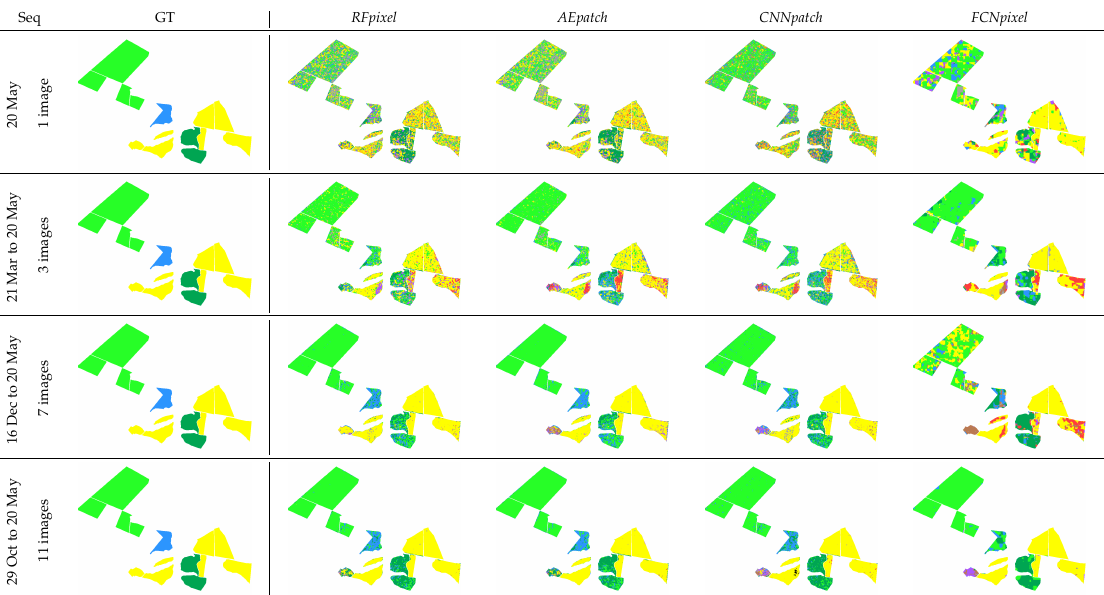
Figure 10. Maps of classification results for selected areas for different sequences length in 20 May. GT stands for ground truth. Same color legend as in Figure